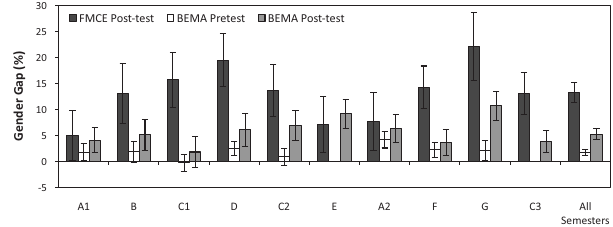
FIG. 2. Pre- and post-test gender gaps (cid:1)(cid:5) S (cid:6) M − (cid:5) S (cid:6) F (cid:2) by semester. The data shown here includes all students who took the pre- and post-BEMA. These data represent seven different instructors and over 2500 students. The instructor is indicated along the x axis. Instructors who taught more than once are labeled with a letter and a number. The error bars represent the standard errors of the mean.